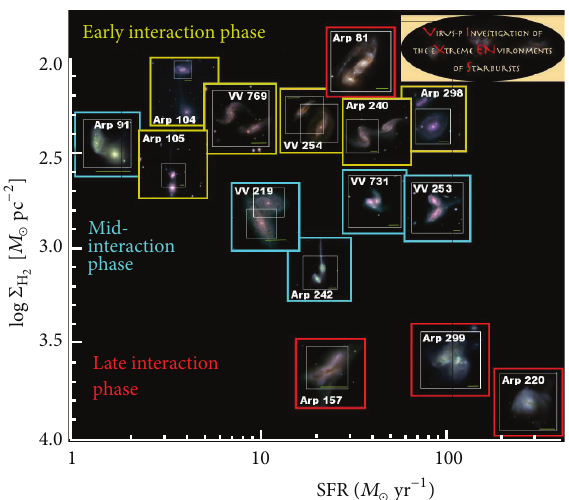
Figure 6: SDSS RGB (i,r,g) images of the VIXENS interacting galaxy sample. White boxes show the Mitchell Spectrograph field of view and the yellow lines indicate a scale of 10kpc. Taken from Heiderman et al.